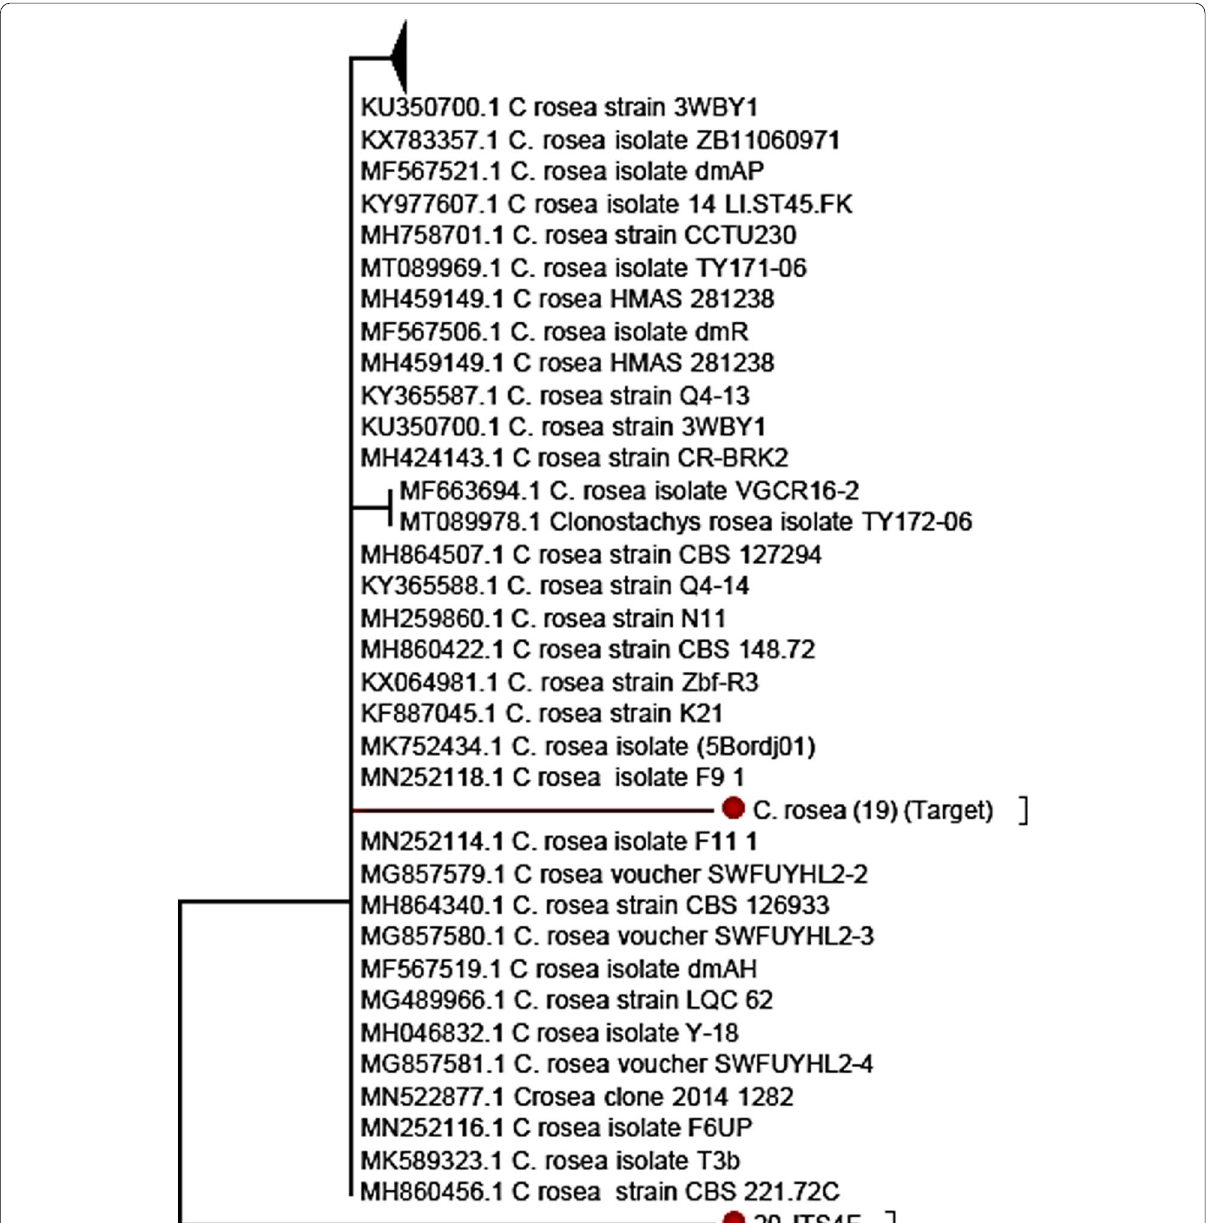
Fig. 1 Phylogenetic tree showing relationships of new submitted isolates of Clonostachys rosea (19-AA80, 20-AA82) based on ITS region NCBI accession number MT366561 and MT366214,